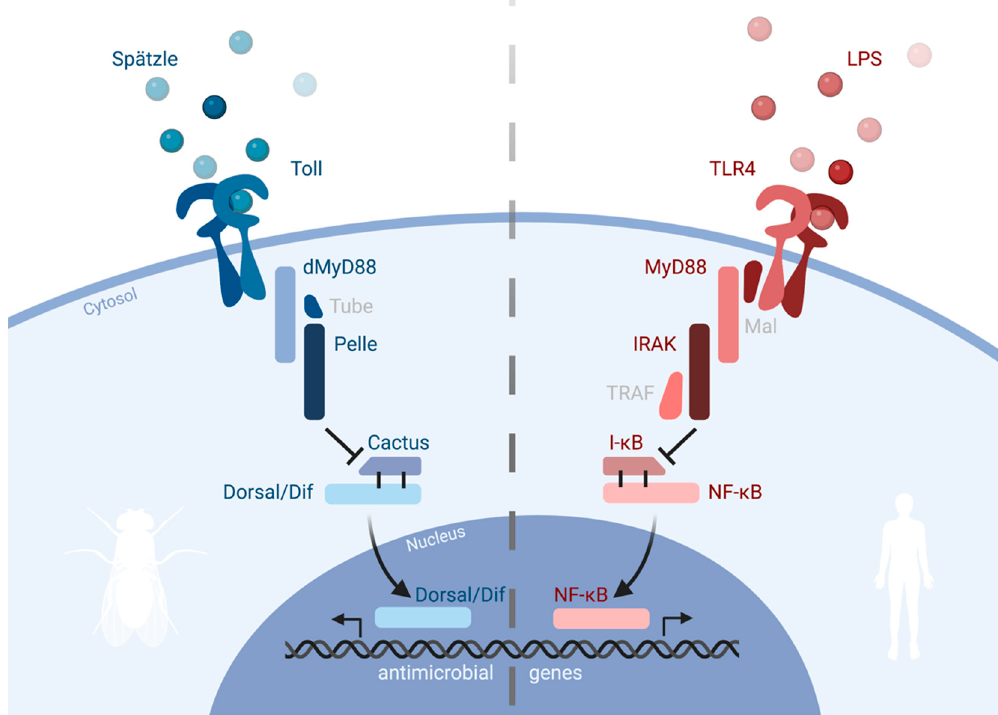
Figure 2. Simplified illustration of the Toll and TLR4 signaling pathways. Homologue components of both pathways are depicted in blue and red, respectively.